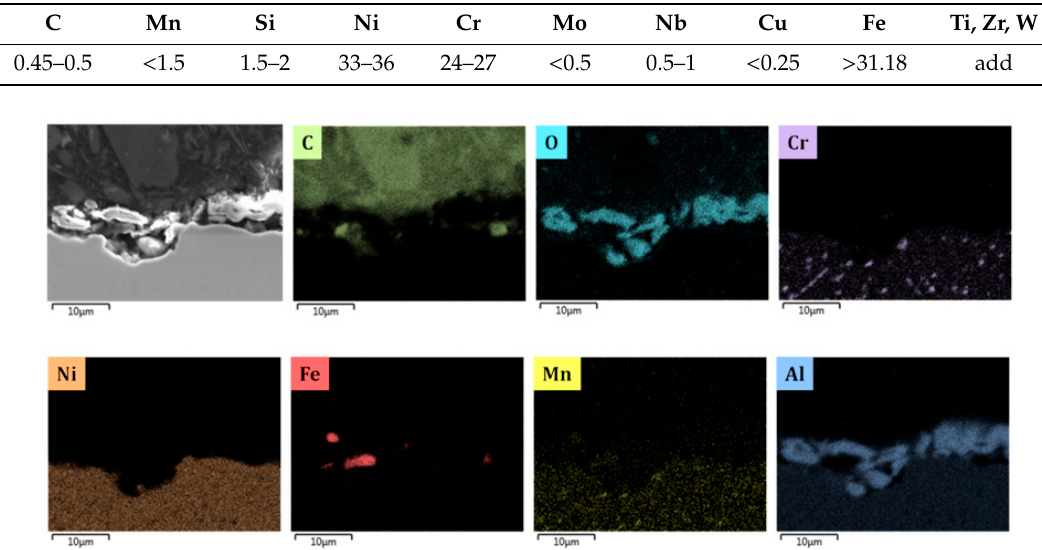
Figure 2. Cross-sectional elemental mappings of a fresh CoatAlloy ™ sample. Magnification: 3000 × , Accelerating Voltage: 15 kV .